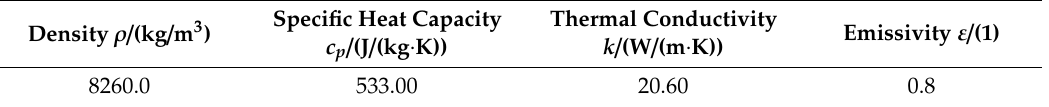
Table 3. Material properties of Inconel 718 used in the simulation of thermocouple temperature change. Data from [27] were used for density, specific heat capacity and thermal conductivity, taking the values for 600 ◦ C for the latter two, for which temperature-dependent data were available. The emissivity is an estimate based on [28] accounting for prolonged exposure to oxygen at temperatures around 600 ◦ C. Exposure to ammonothermal reaction media likely has similar e ff ects, given the visual appearance of used